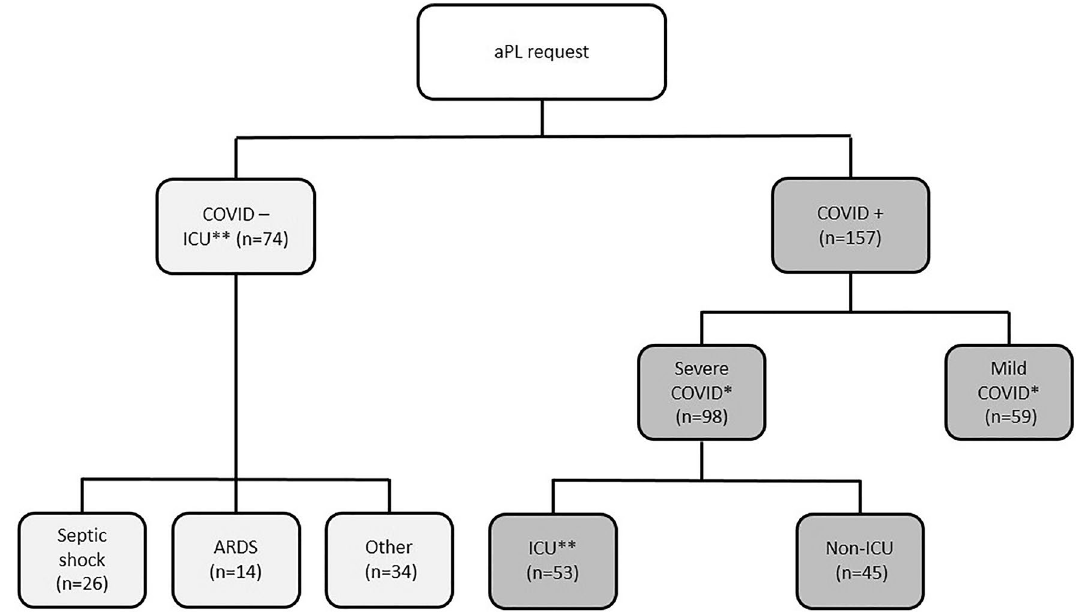
Figure 1. Flow Chart of patients. ARDS acute respiratory distress syndrome, ICU Intensive Care Unit. Two comparison were performed in this study: one between severe and mild COVID groups (*) and another between COVID ICU and non COVID ICU groups